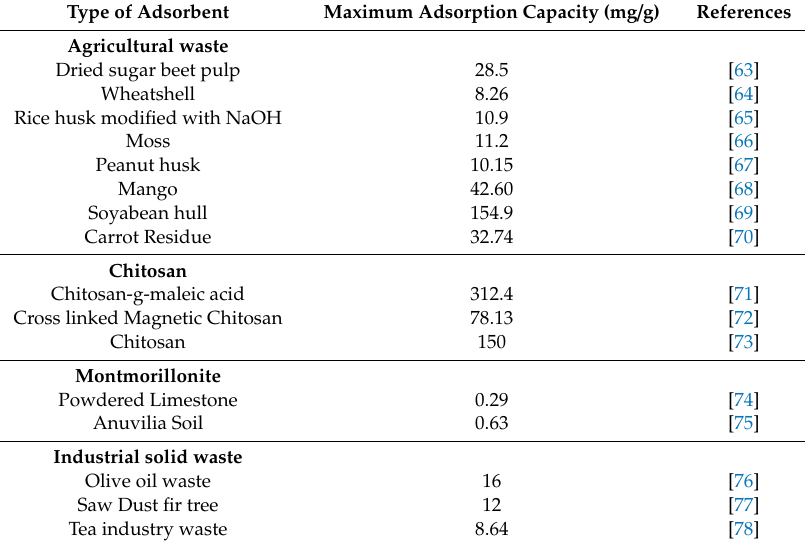
Table 4. Maximum adsorption capacity of different natural adsorbents for the removal of copper in aqueous solution.